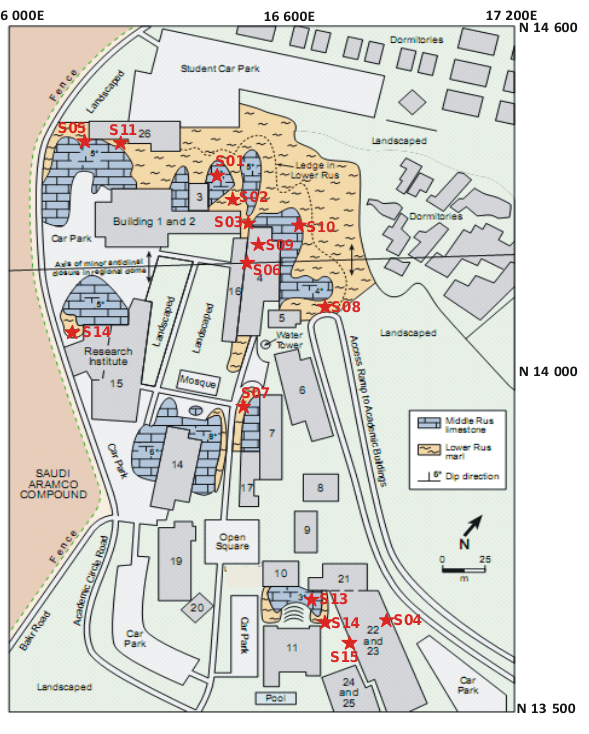
Figure 1. Map showing KFUPM campus and the location of geophones (Modified after 3 Fig. 1. Map showing KFUPM campus and the location of geo- Weijermars, 1999). 4 phones (modified after Weijermars, 1999).